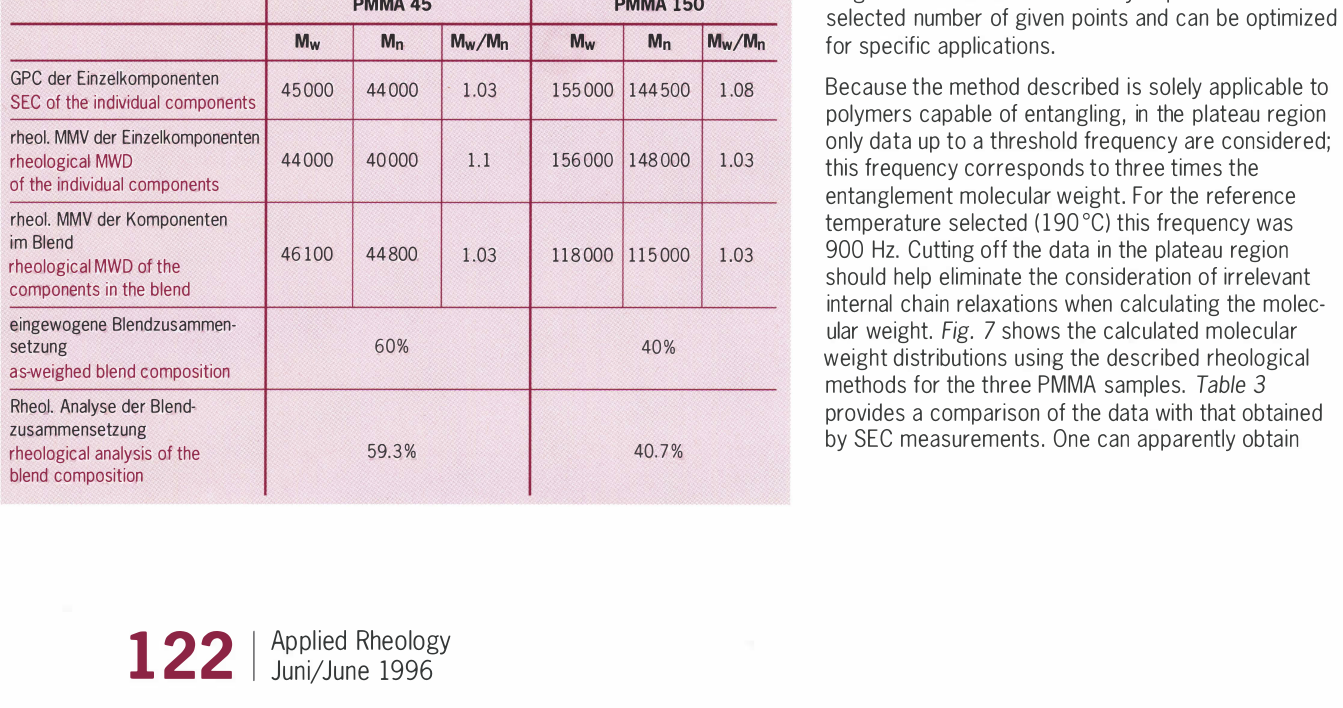
Tabelle 3: Vergleich der Charakterisierungsmethoden GPC und Rheologie fur die Reinkomponenten und das Blend M4. Table 3: Comparison of GPC and rheological characterization methods for determining the molecular weight and MWD of the pure components and blend M4.